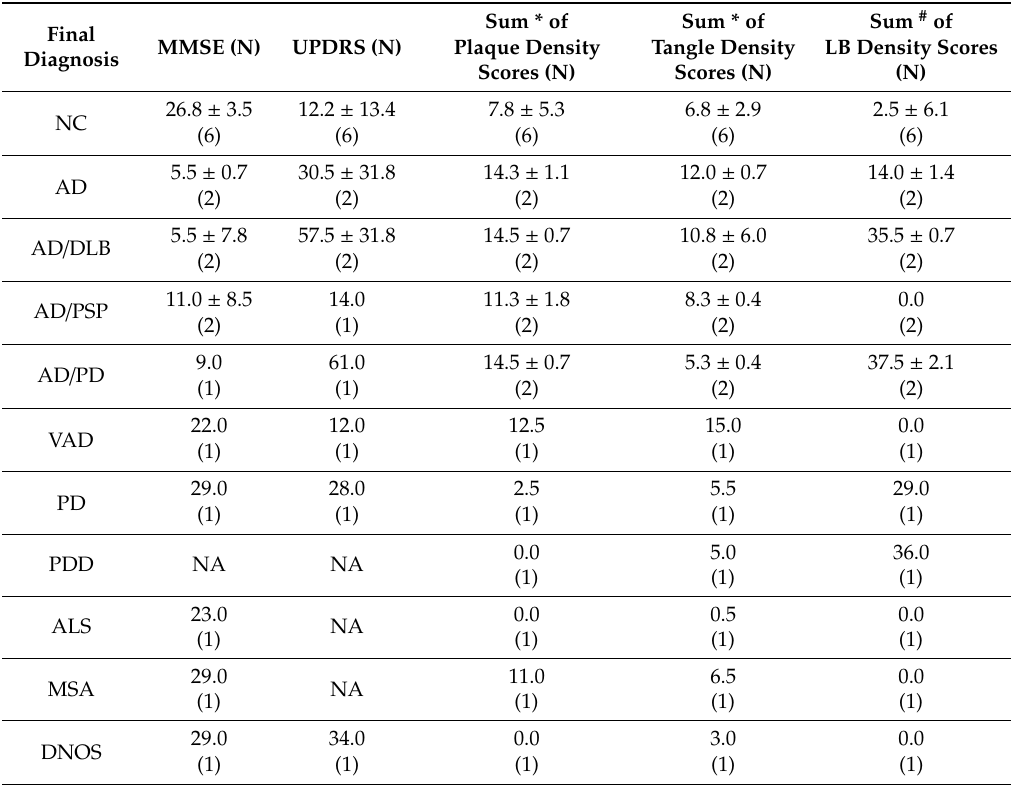
Table 2. Measures of last memory and movement functions in relation to completed neuropathology for 20